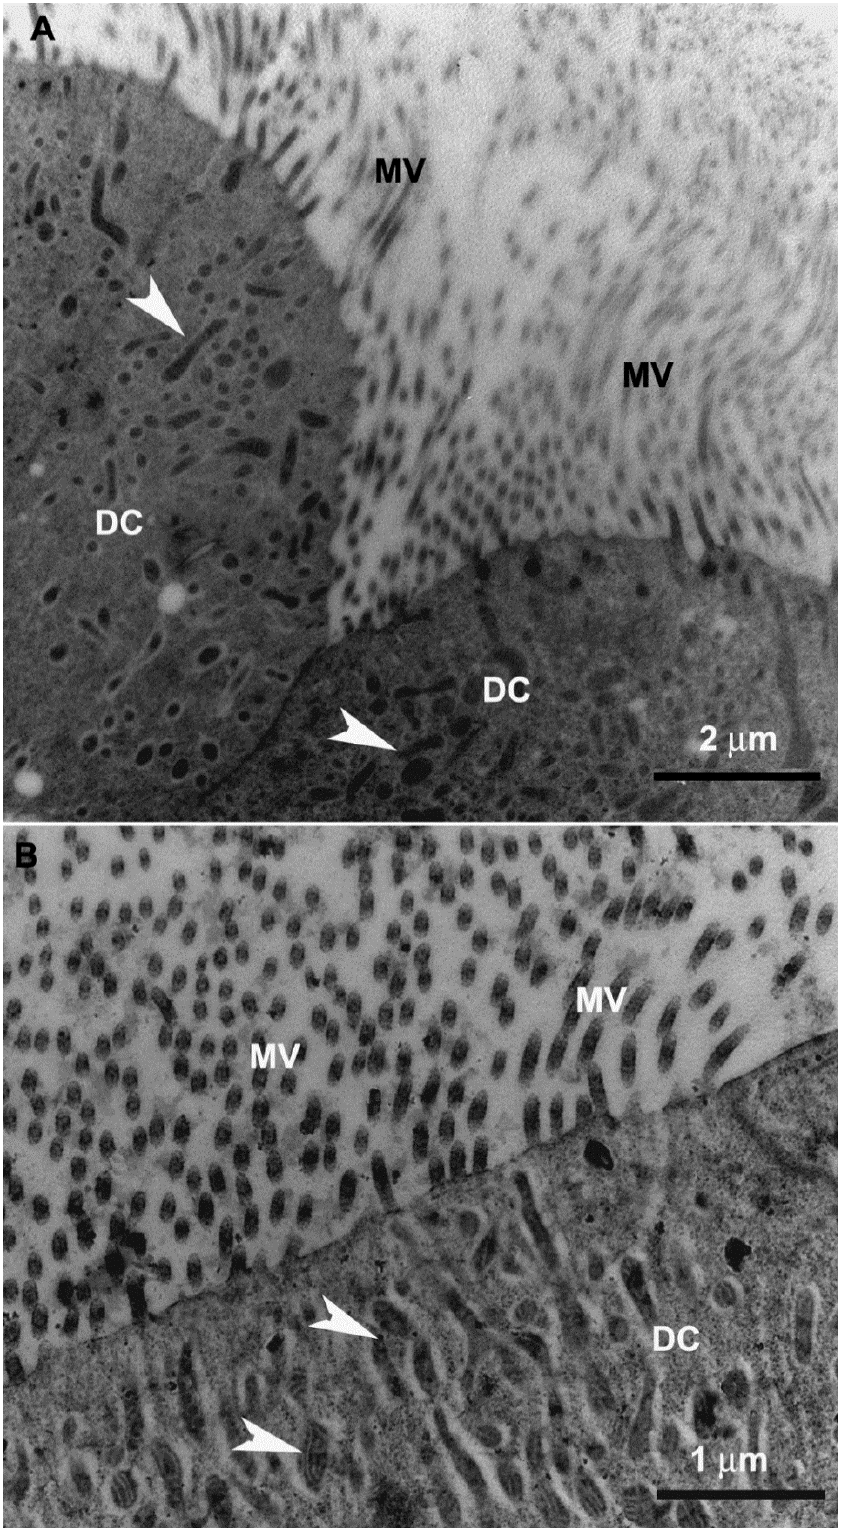
Figure 4. Transmission electron micrographs of digestive cell in the posterior midgut region of Friesella schrottkyi worker. ( A ) Apical region of the digestive cell (DC) with some long microvilli (MV) and cytoplasm with mitochondria (arrowheads). ( B ) Apical region of the digestive cell (DC) showing spaced microvilli (MV) and cytoplasm with mitochondria (arrowheads).